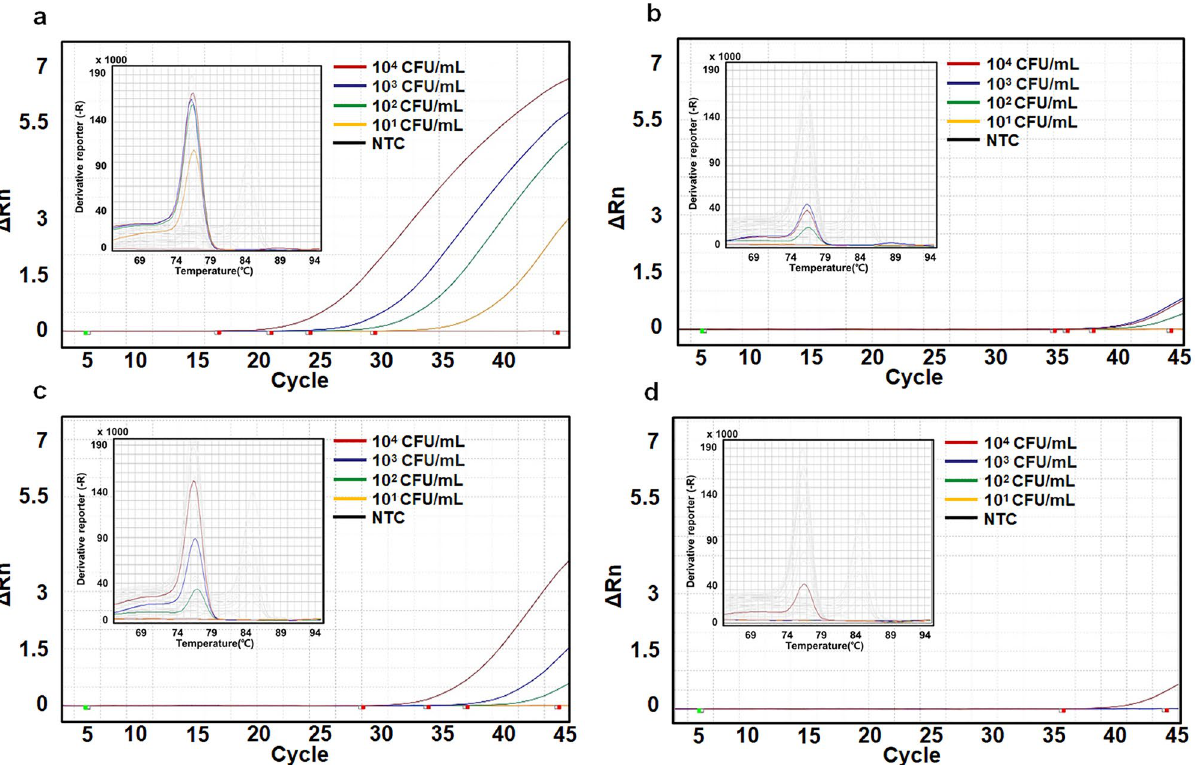
Figure 5. Results of real-time PCR for the detection of S. aureus . Each figure shows amplification and melting curves. The CFU (colony forming unit) values in each figure are the concentrations at the time of spiking and are independent of specimen incubation. The quantified actual numbers of S. aureus in plasma with different concentration (10 1 –10 4 CFU/mL) after 12 h specimen incubation at RT are 88.6 ± 14.7, 606 ± 144, 7,210 ± 1070, and 54,000 ± 10,600, respectively (Supplementary Table S3). Nucleic acid amplification and melting curves in each figure are dependent on specimen incubation. ( a ) Real-time PCR results after 12 h incubation and with S. aureus captured by MNBs, ( b ) after 12 h incubation and with S. aureus uncaptured by MNBs, ( c ) without prior specimen incubation and with S. aureus captured by MNBs, ( d ) without prior specimen incubation and with S. aureus uncaptured by